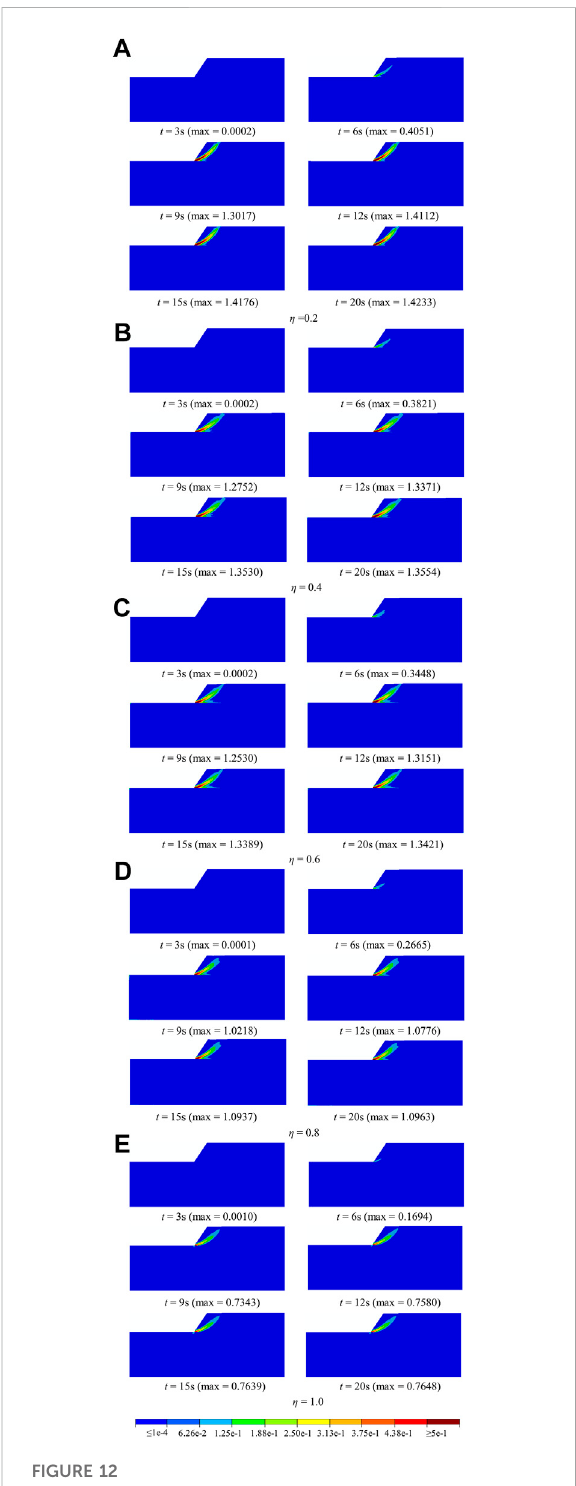
FIGURE 12 Plastic strainnephogramsoftheslope atdifferenttimingwith different impedance ratios. (A) η = 0.2. (B) η = 0.4. (C) η = 0.6. (D) η = 0.8. (E) η =